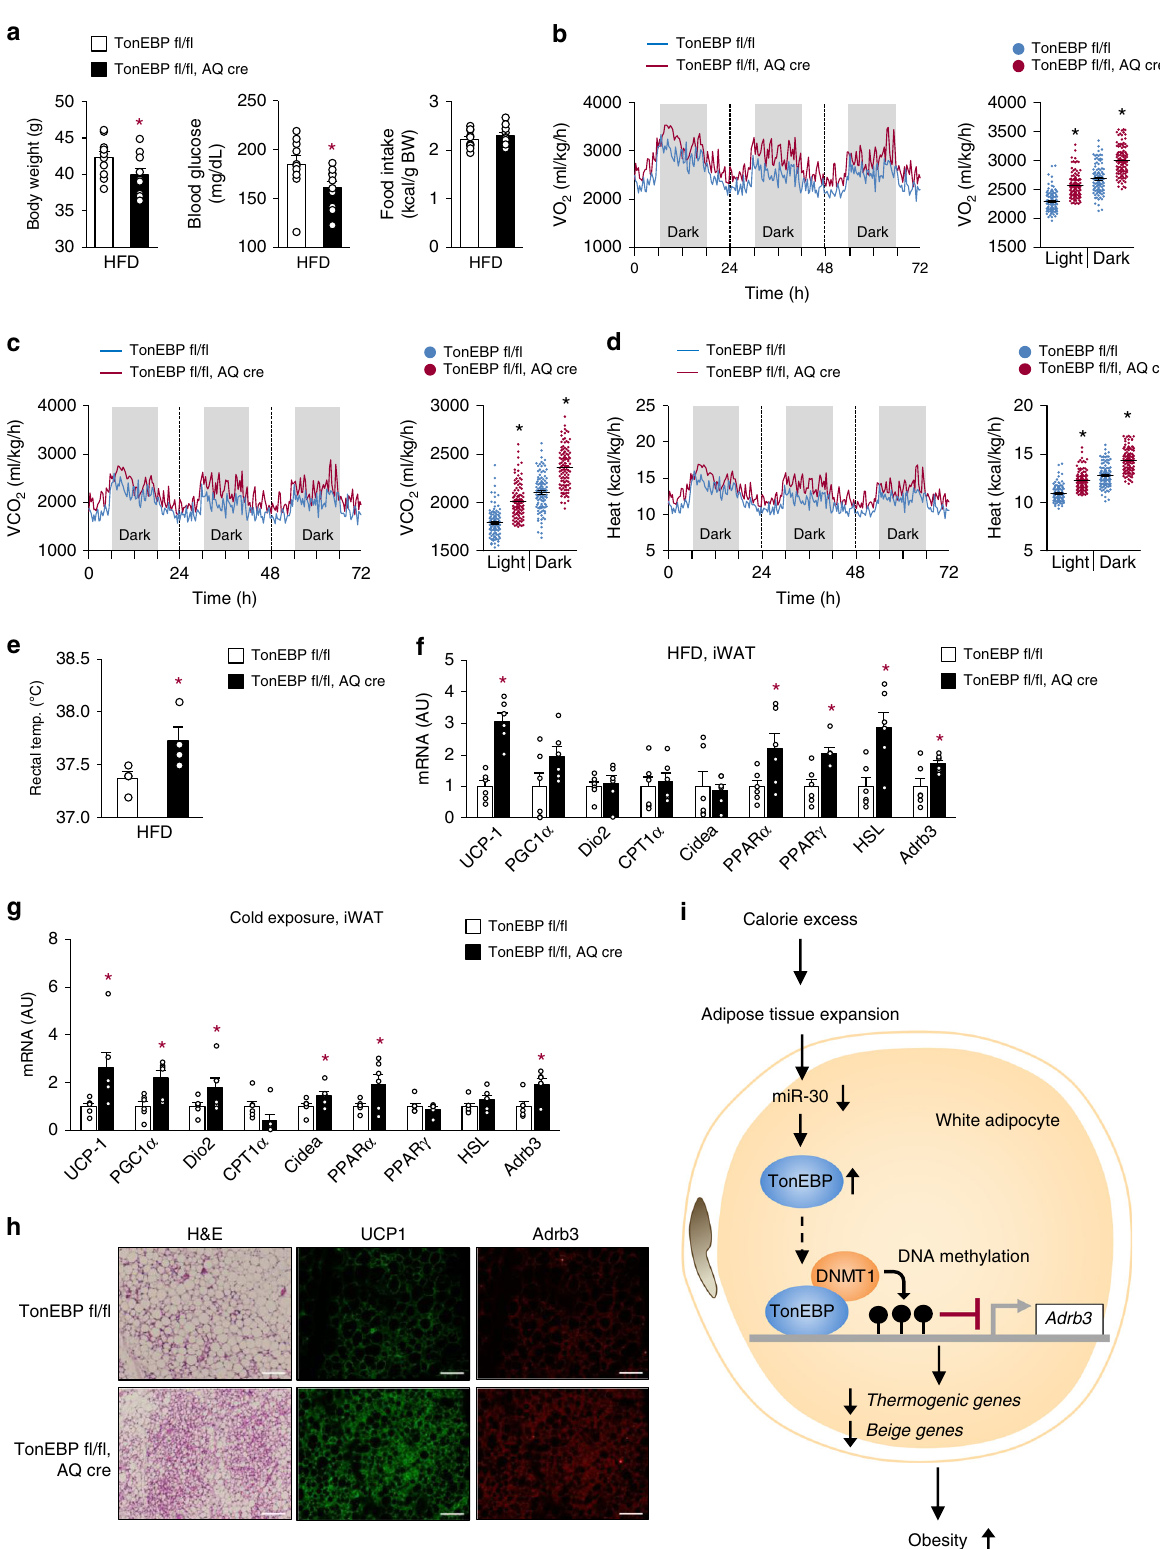
antibody 5 were used for immunoblotting at 1:1000 dilution. Uncropped western blots of immunoprecipitated proteins are shown in Supplementary Fig. 13. Chromatin immunoprecipitation assay . Cells were grown in 10-cm-diameter culture dishes. Fixation was performed with 1% formaldehyde at room temperature for 10min. The fi xation was stopped with 0.125 M glycine for 5min at